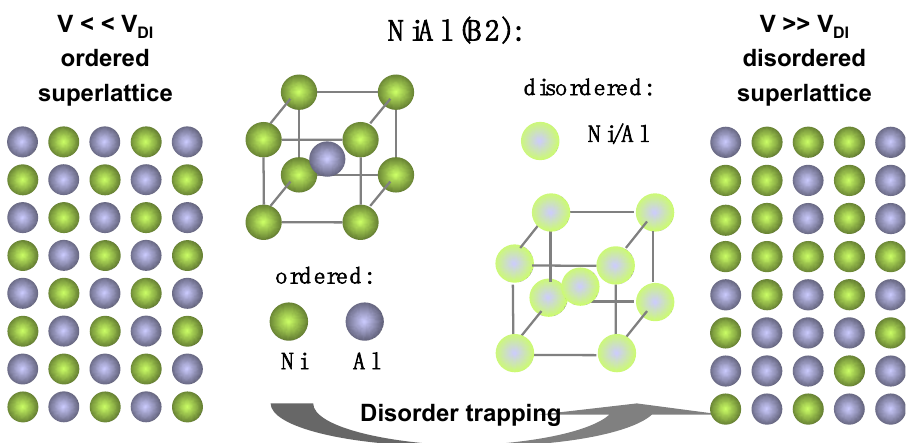
Figure 11. Schematic illustration of ordered growth forming an ordered superlattice structure at small dendrite growth velocity ( left ) disorder trapping at higher velocity leading to a disordered superlattice structure ( right ). Similar as for solute trapping the atomic diffusive speed is the essential parameter separating the regions of equilibrium and non-equilibrium